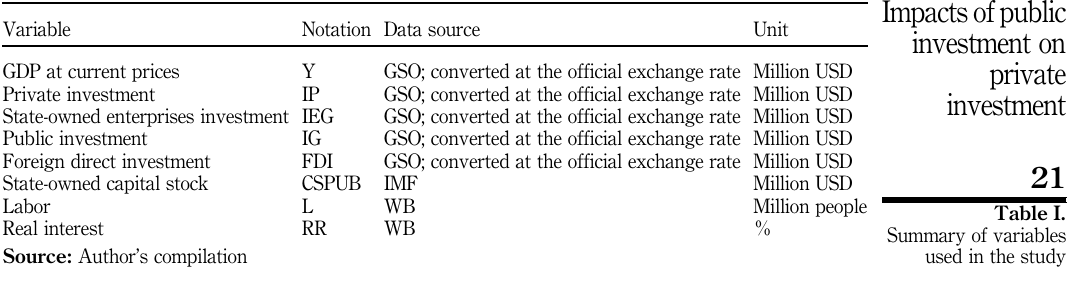
Table I. Summary of